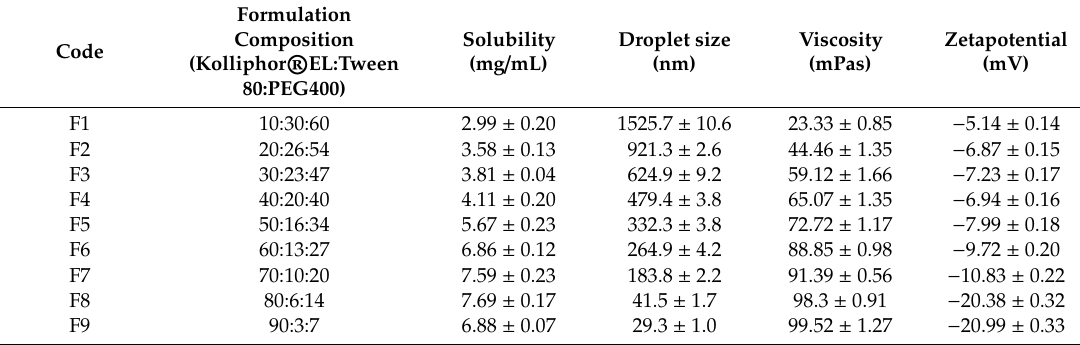
Table 2. Solubility, droplet size, viscosity, and zetapotential for the mixed micellar formulations.